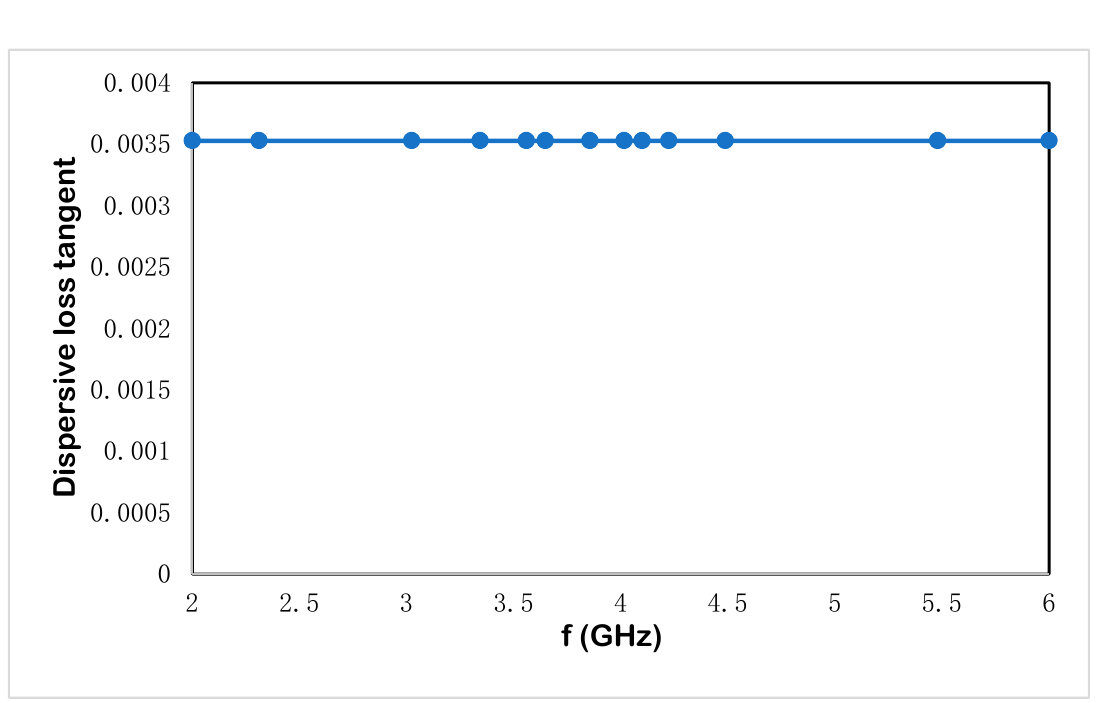
Figure 9. Dispersive loss tangent for the proposed split ring enclosed microwave sensor. Table 2. Different radiation properties for the proposed sensor. Resonant Frequency at 3.56 GHz